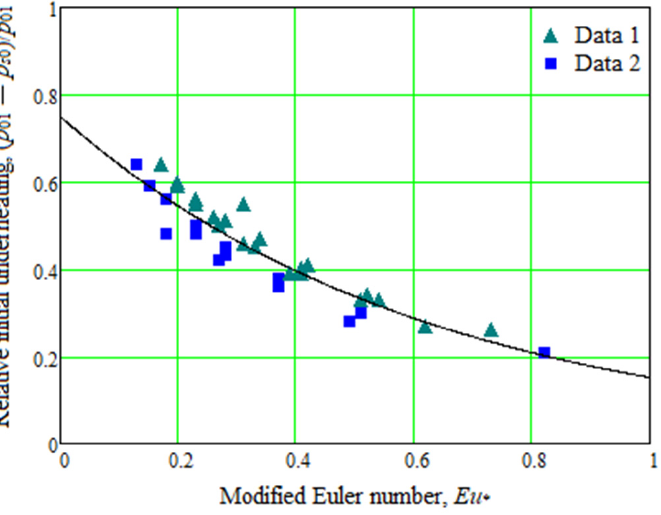
Figure 7. Dependence of the relative initial underheating on the modified Euler number.